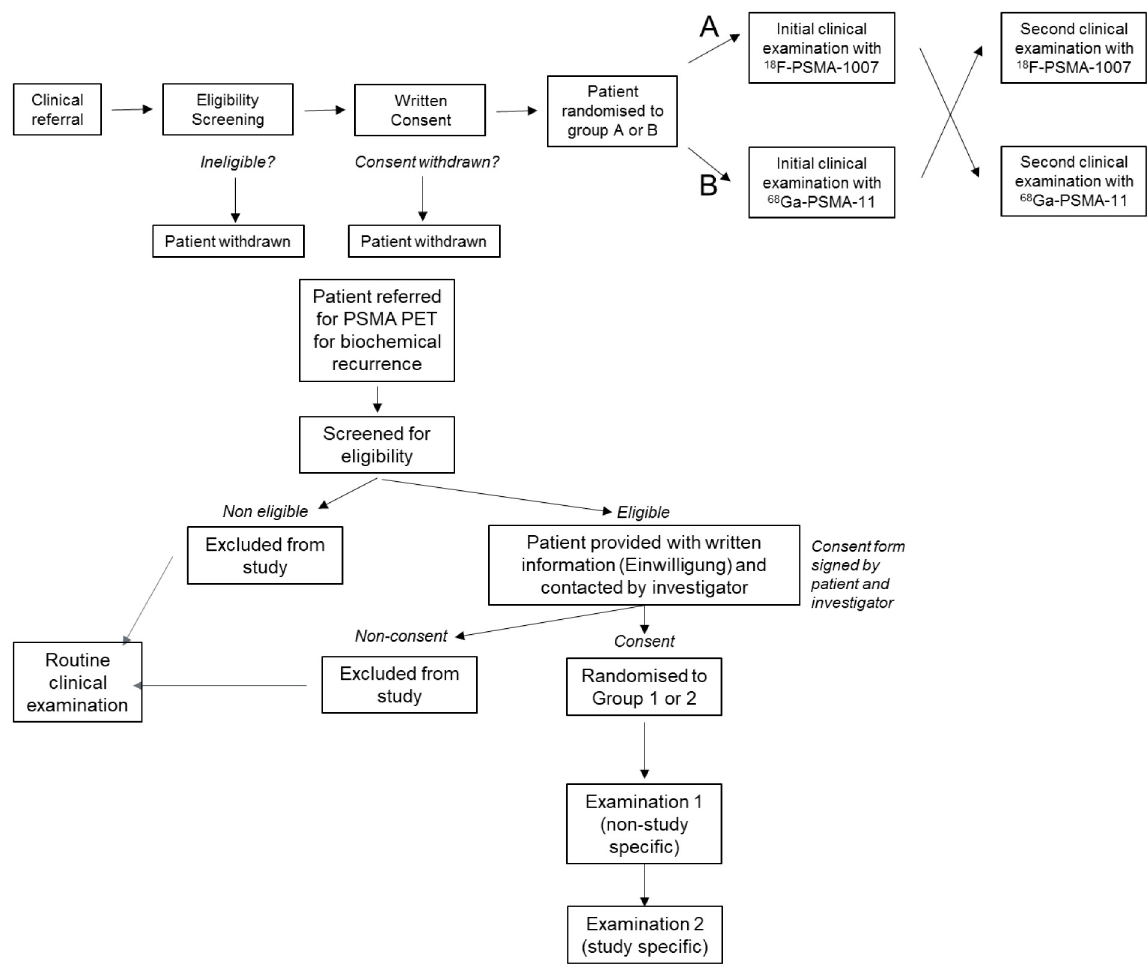
Fig 2. CONSORT study flow